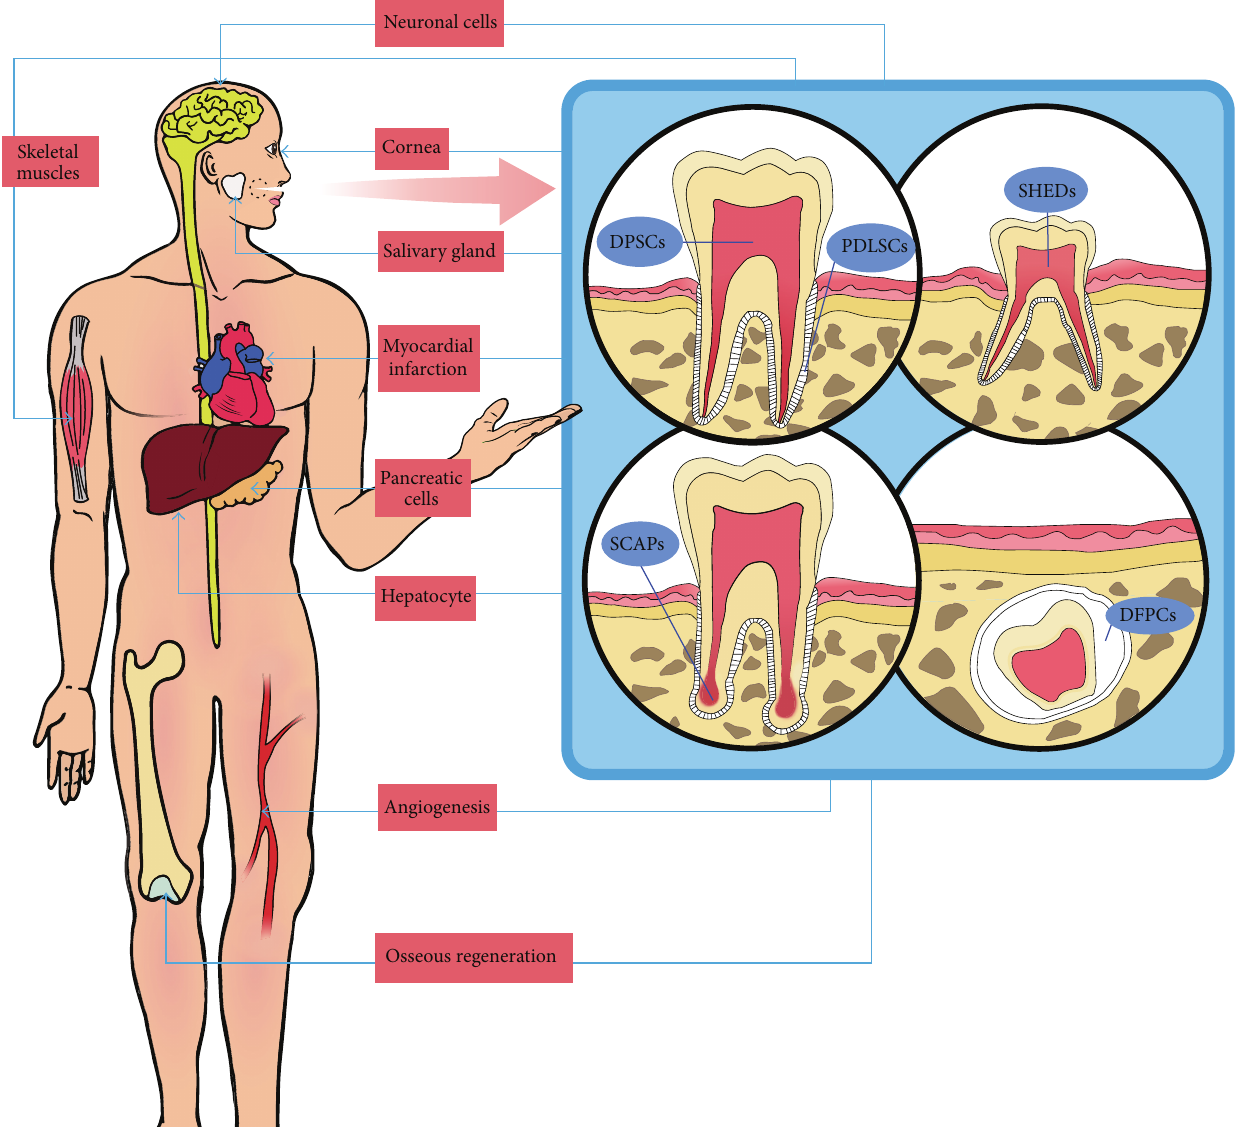
Figure 1: Regeneration of various tissues or organs from tooth derived stem cells. Stem cells from tooth related structures can be used to regenerate not only dentin-pulp complex but also various tissues or organs of body, such as bone, vascular system, nerve, liver, pancreas, salivary glands, skeletal muscle, and cornea. DPSCs (dental pulp stem cells), PDLSCs (periodontal ligament stem cells), SHEDs (stem cells from human exfoliated deciduous teeth), SCAPs (stem cells from apical papilla), and DFPCs (dental follicle progenitor